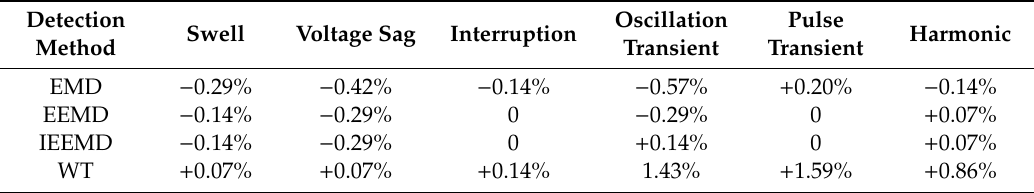
Table 5. The relative error of the disturbances end time point.